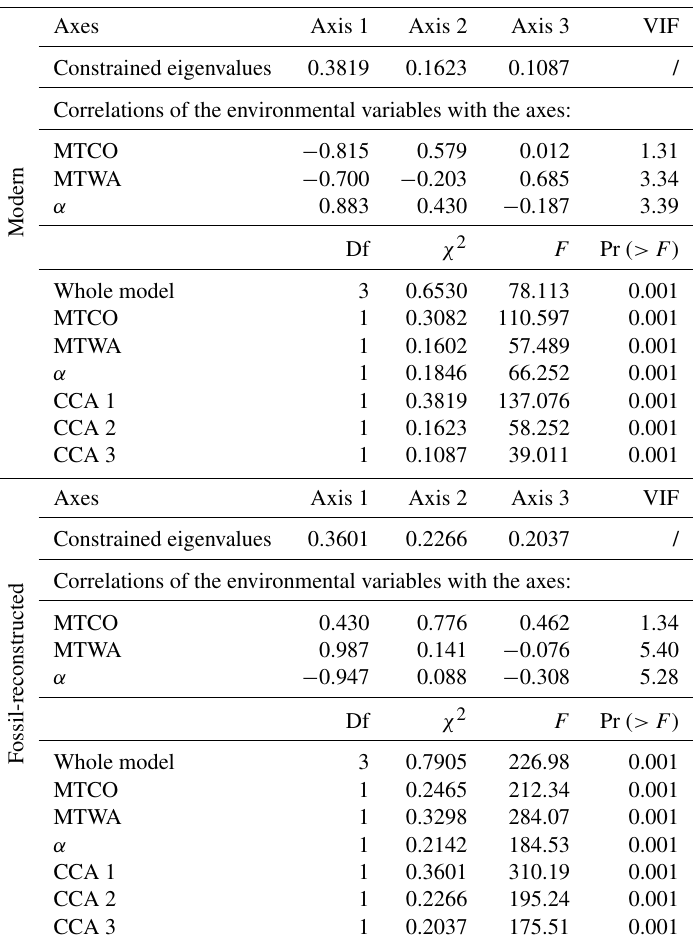
Table 3. Canonical correspondence analysis (CCA) result of modern and fossil-reconstructed MTCO, MTWA and α . The summary statistics for the ANOVA-like permutation test (999 permutations) are also shown. VIF is the variance inflation factor, Df is the number of degrees of freedom, χ 2 is the constrained eigenvalue (or the sum of constrained eigenvalues for the whole model), F is significance and Pr ( >F ) is the probability. The CCA plots can be found in Fig.